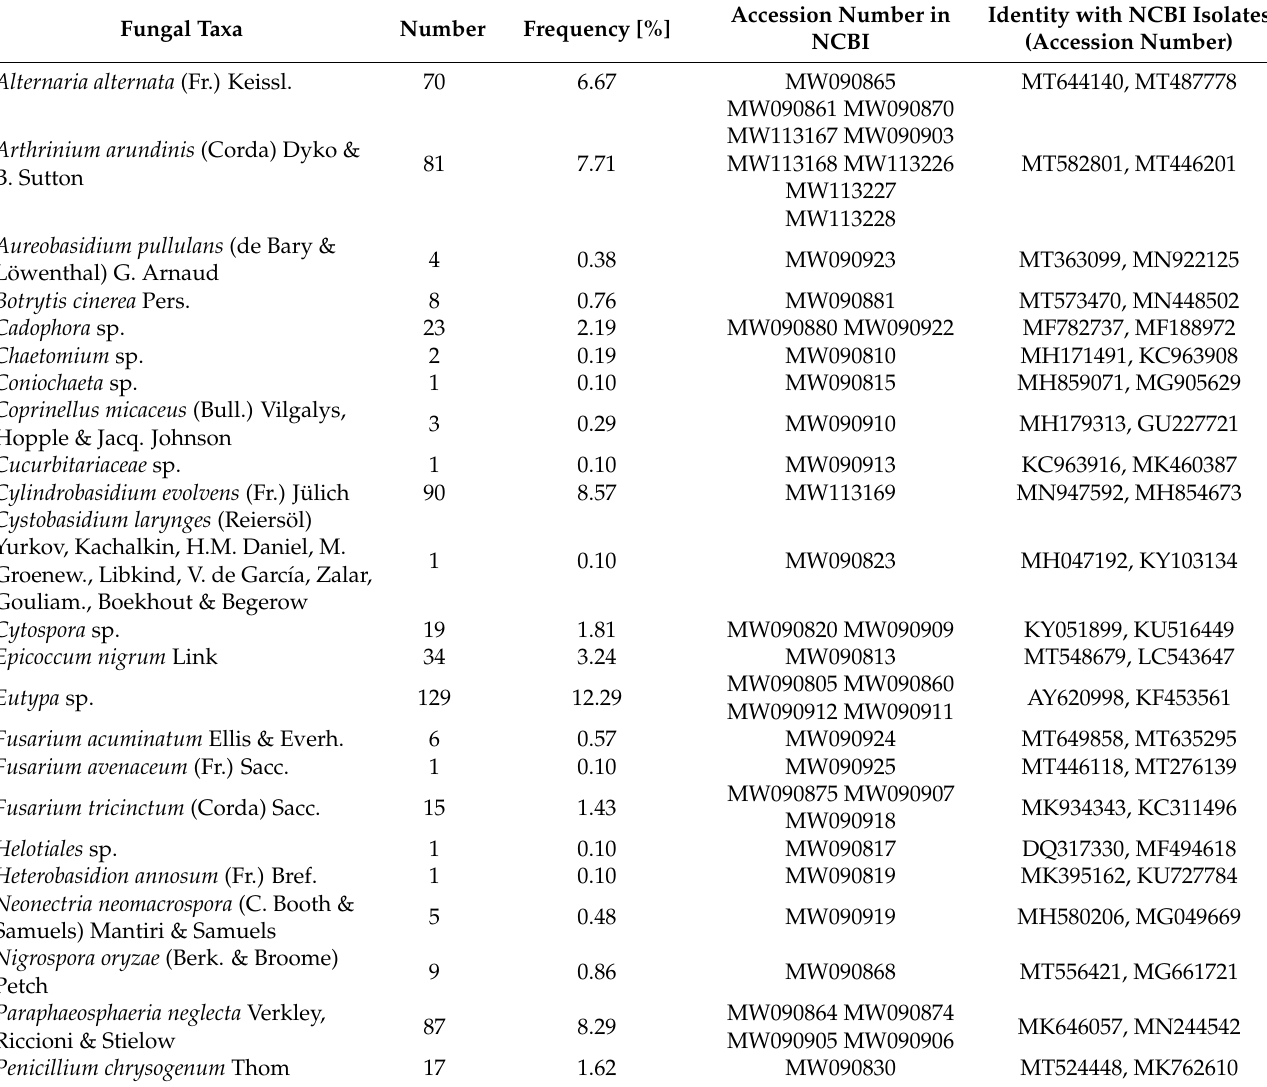
Table 2. Fungi isolated from sapwood of bark-stripped Abies alba . Molecular identification based on ITS rDNA region sequences using BLAST method and maximum likelihood ITS